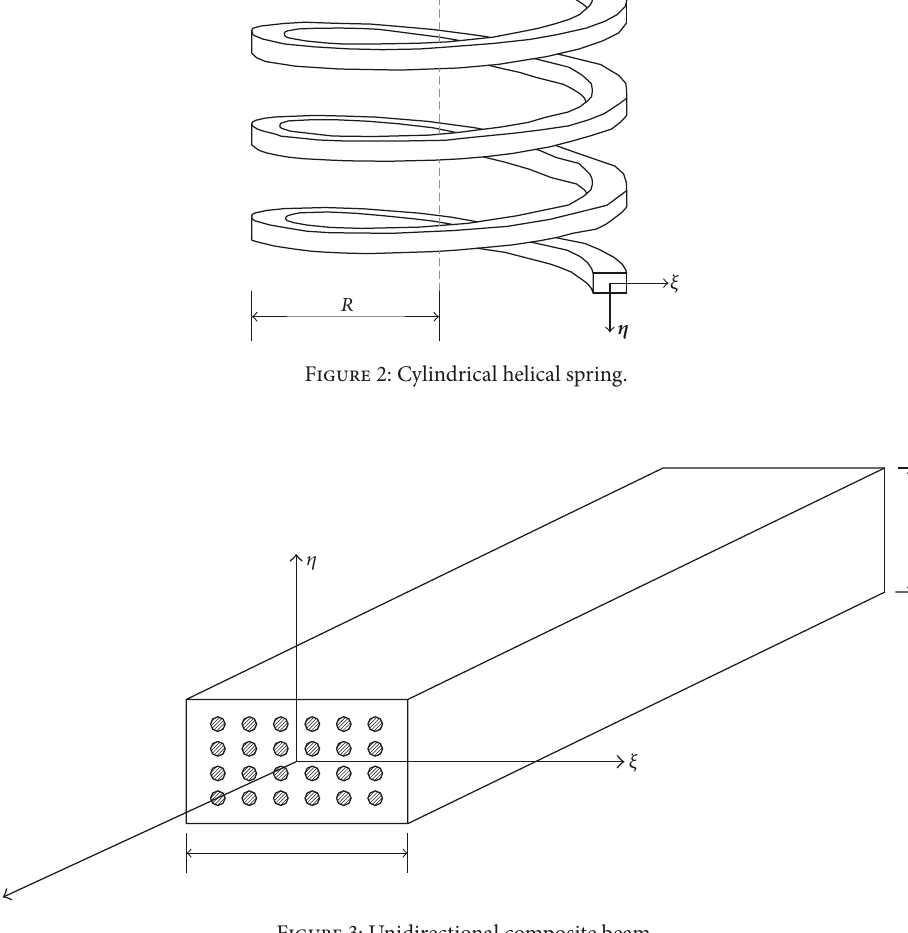
Figure 3: Unidirectional composite